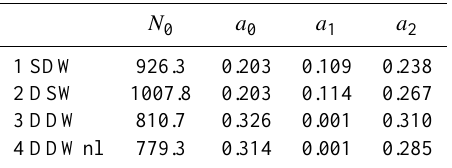
Table 6. Modified calibration parameters for the four weighting ap- proaches. N 0